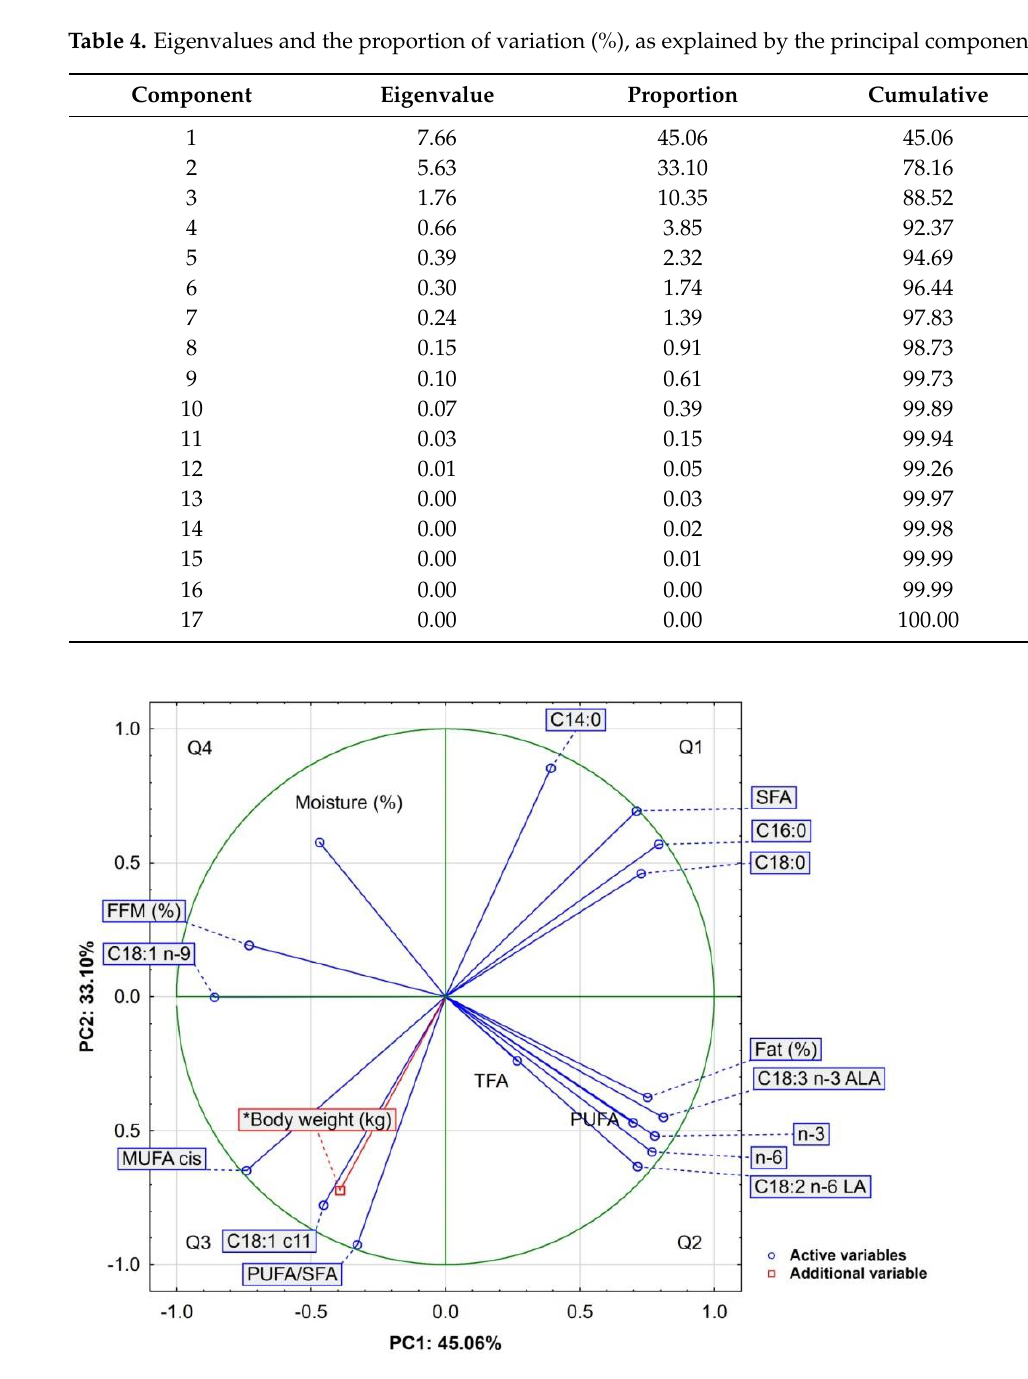
Figure 1. Projection of variables in a two-factor plane (PC1 × PC2); FFM (%) — fat-free mass content; fat (%) — fat content; TFA — trans fatty acids.